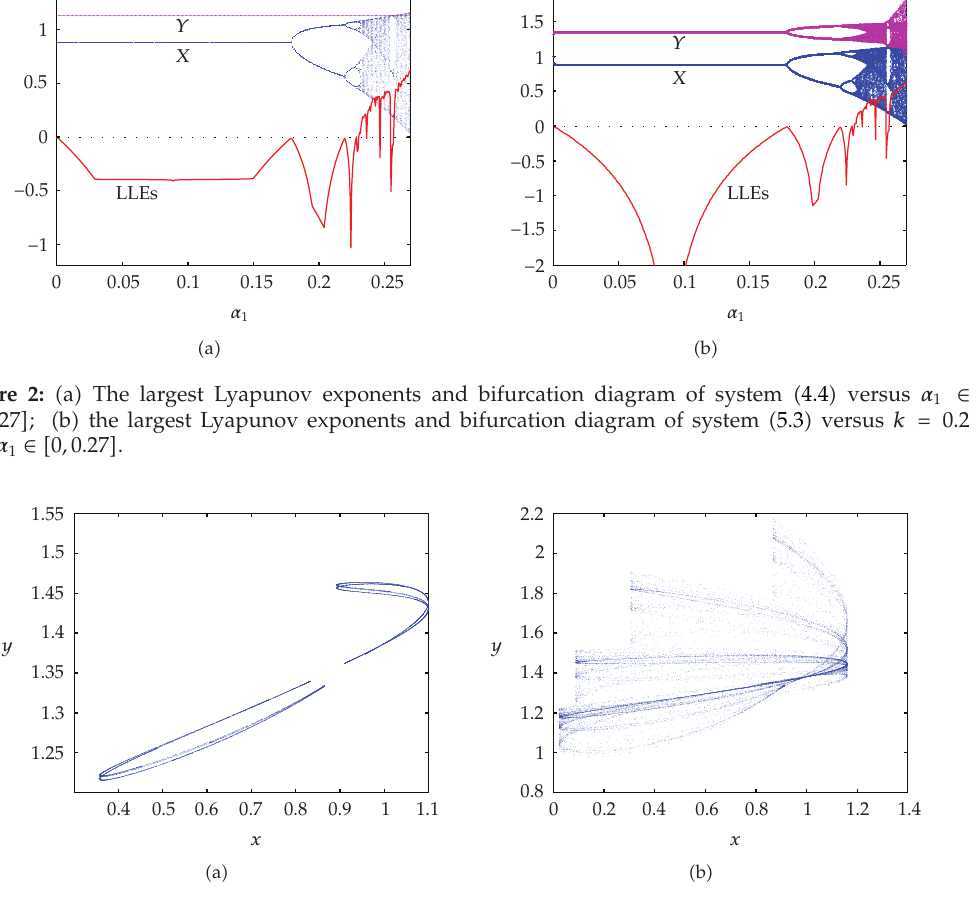
Figure 2 (cid:2) a (cid:3) , while firm Y undergoes neither bifurcation nor chaos. In system (cid:2) 5.3 (cid:3) , when one fixes k (cid:7) 0 . 2, he can get the largest Lyapunov exponents